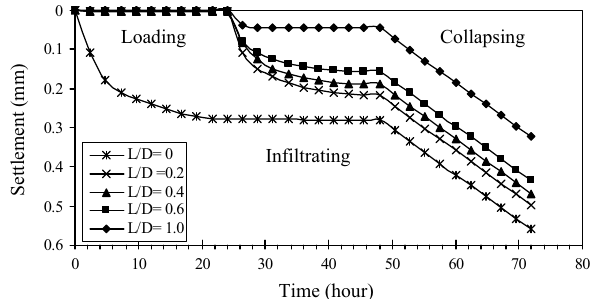
Figure 9: Settlement with time during di ff erent stages and skirt